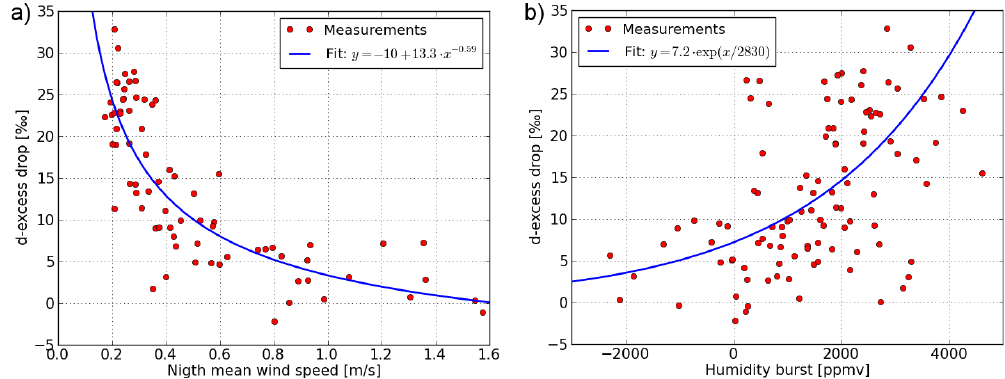
Figure 10. Deuterium excess drop vs. (a) night mean wind speed and (b) morning humidity